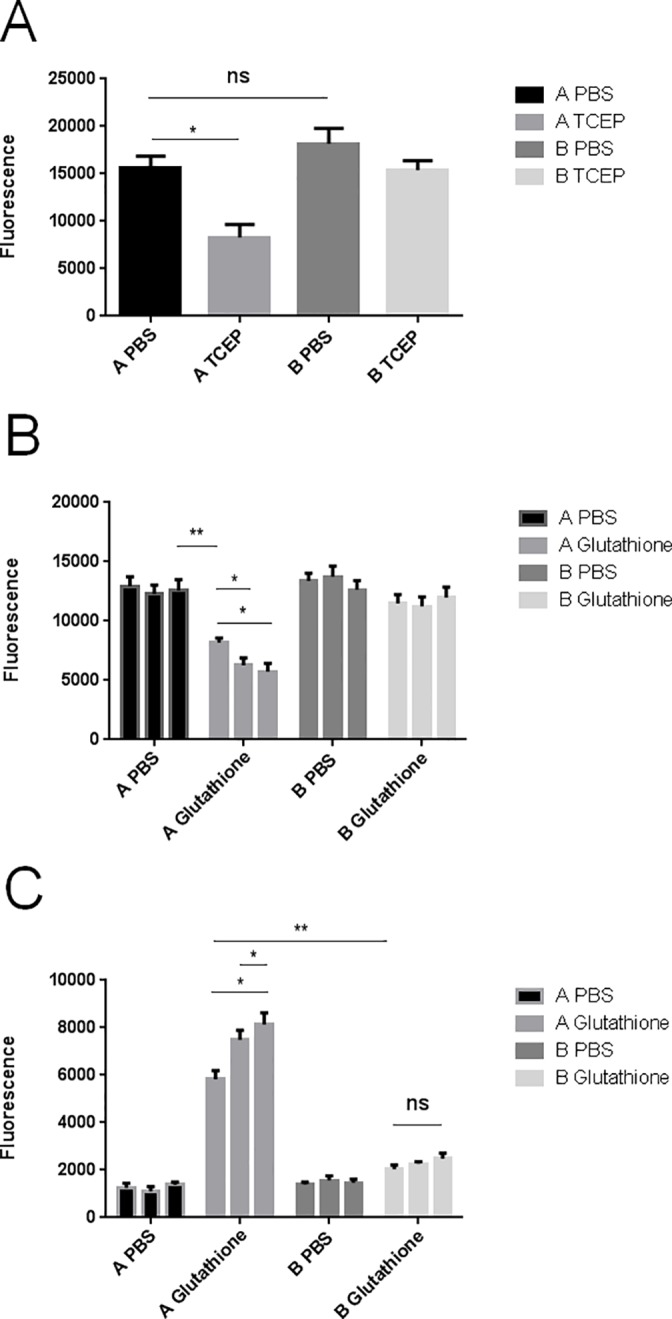
Cleavage of the disulfide bond with TCEP or glutathione in vitro.A) Release of fluorescent peptide into solution following cleavage of the disulfide bond in conjugates using TCEP in vitro. Conjugates A and B (30 μg) were treated with PBS (100 μL) or TCEP (100 μL, 50mM pH 7) for 30 min at RT. After washes, pellets were re-suspended in PBS (100 μl) and fluorescence was measured (excitation 488, emission 520). Error bars represent SEM. B and C) Release of the fluorescent peptides into solution following cleavage of the disulfide bond in the conjugates using glutathione in vitro. Conjugates A and B (30 μg) were treated with PBS (100 μL) or glutathione (100 μL, 10 mM, pH 7.2) for 30, 60 or 120 min at RT as represented by the 3 bars left to right. After centrifugation, pellets (B) and supernatants (C) were collected and the fluorescence measured (excitation 488, emission 520). Error bars represent SEM. All experiments were repeated three times.